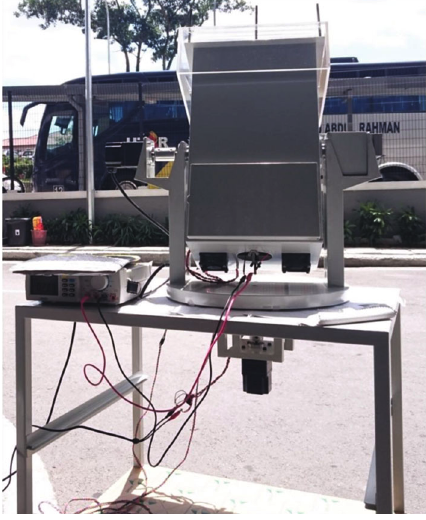
Figure 14: Experiment setup to study the pointing error of prototype mobile sun-tracking system under stationary